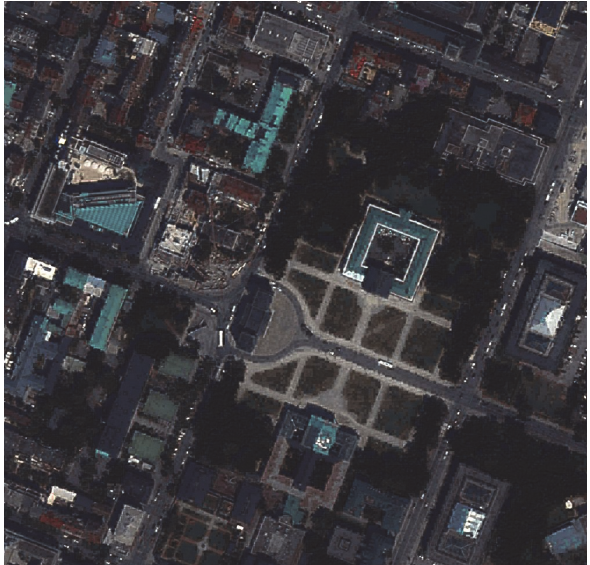
Figure 7. Reconstruction using HPFM (Palubinskas